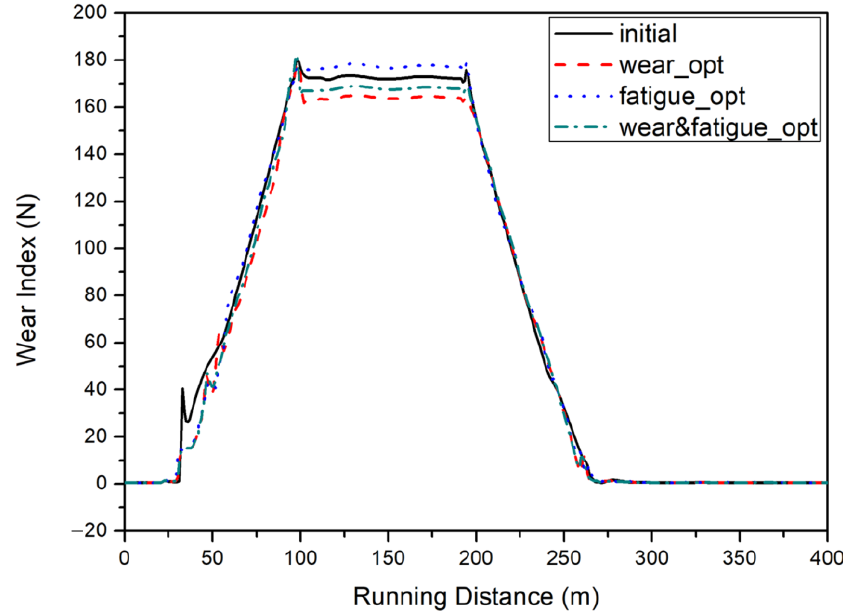
Figure 13. Wear number of wheel profile.